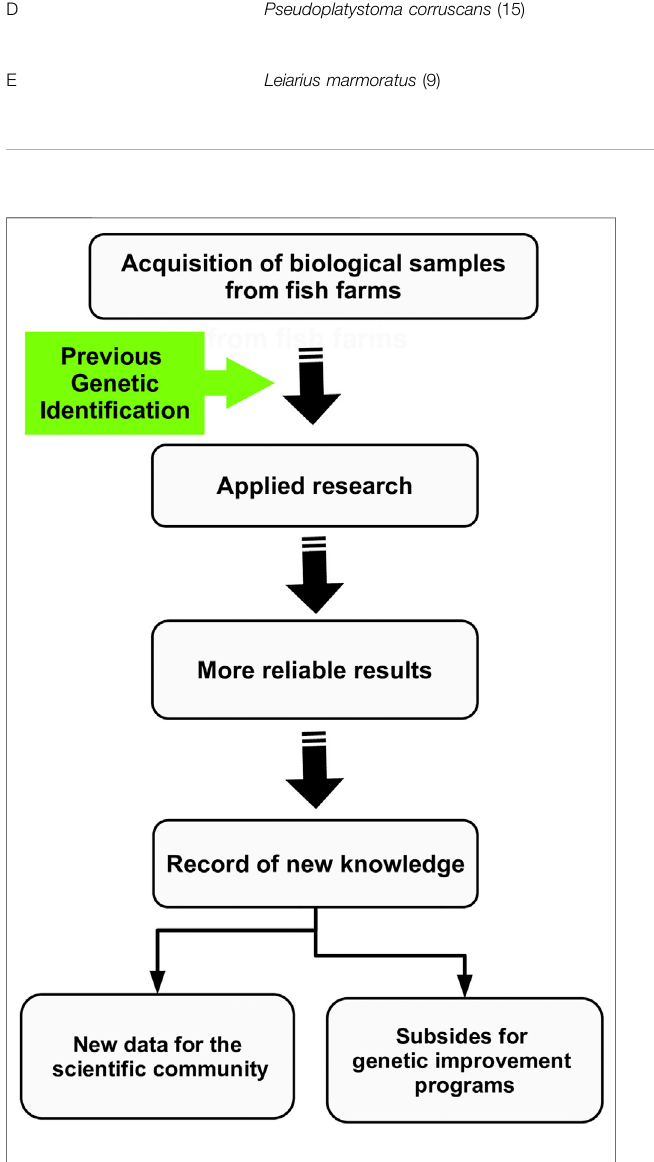
FIGURE 2 | Illustrative scheme demonstrating the importance of previous genetic diagnosis of samples for the correct identi fi cation of species and subsidies for research projects and future breeding